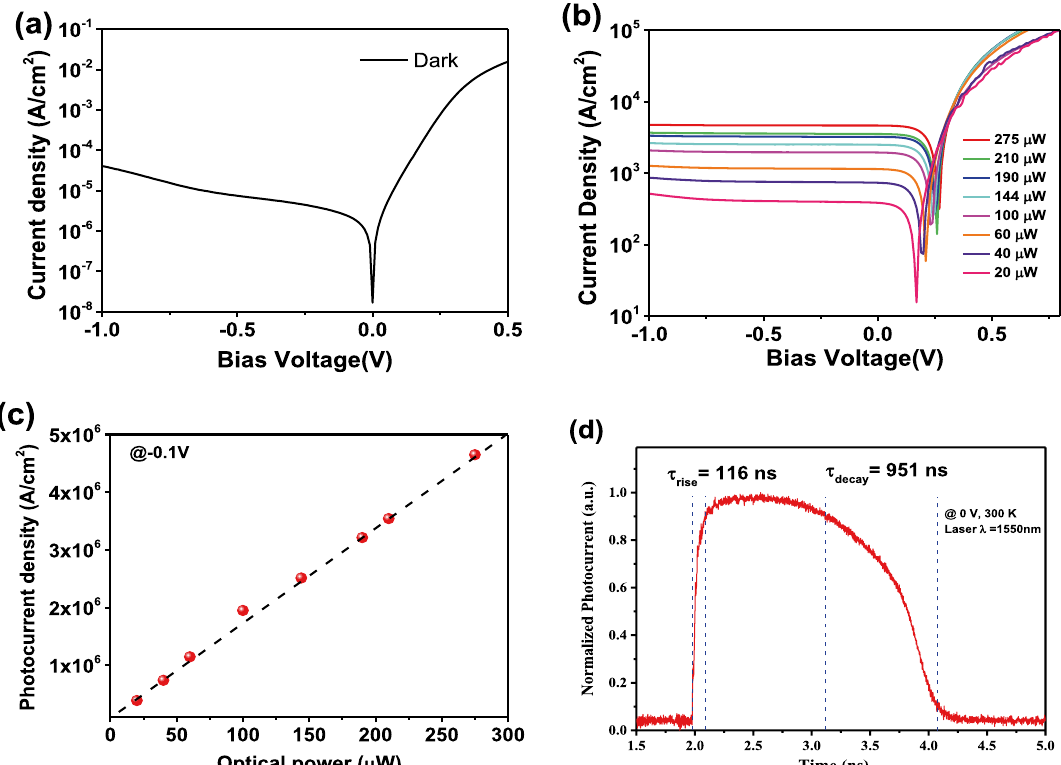
Figure 5. J–V responses of the InGaAs flexible detector under flat condition: ( a ) At darkness and ( b ) Different input optical power levels. ( c ) Photocurrent (PC) as a function of the optical power, the solid line represents a linear fitting of the experimental data. ( d ) Transient response spectrum of the detector under 0 V, inspired by a femtosecond laser (λ = 1550 nm, P = 200 μW with 100 fs pulse